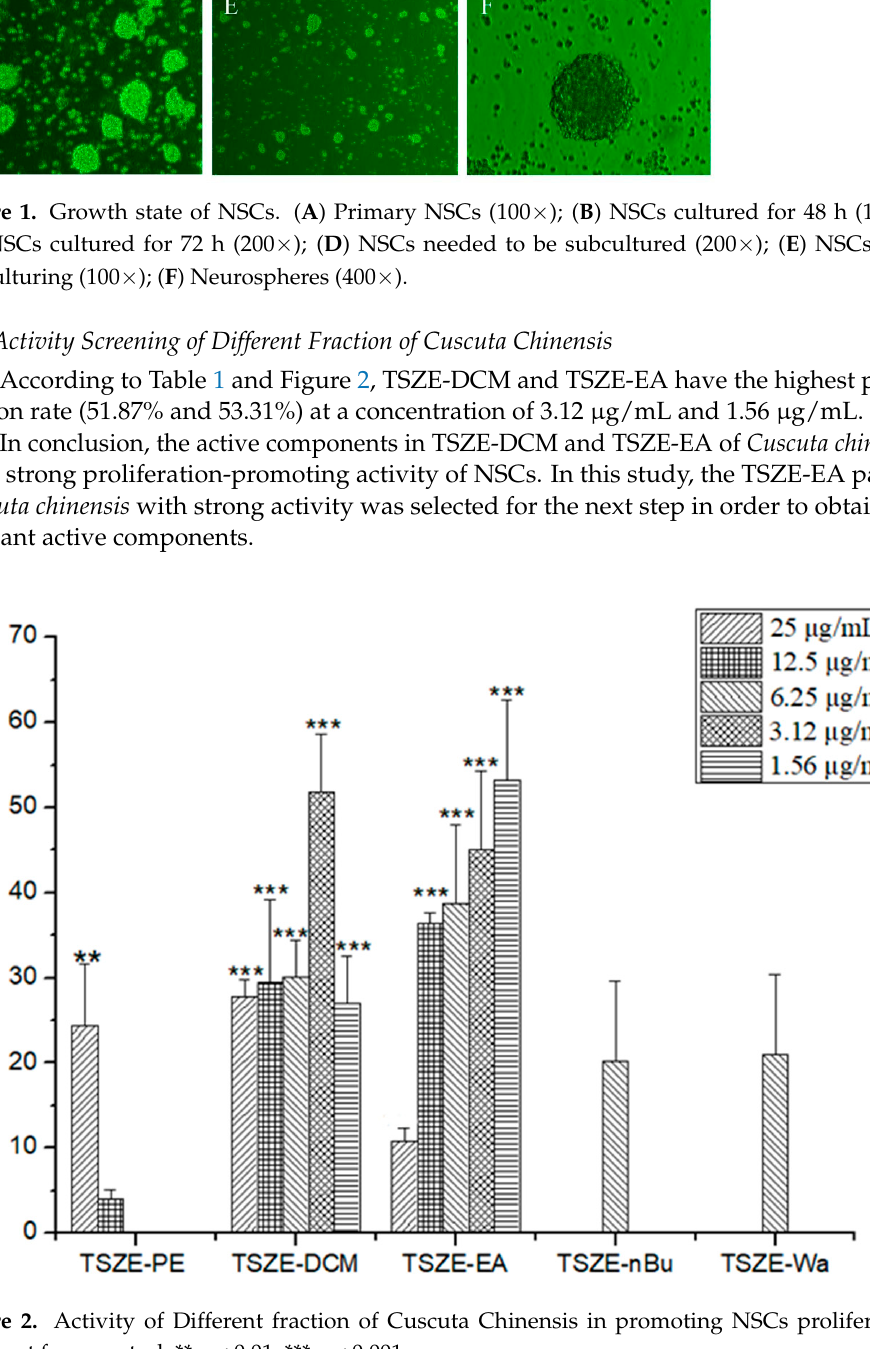
Figure 2. Activity of Different fraction of Cuscuta Chinensis in promoting NSCs proliferation. Different from control, ** p < 0.01, *** p < 0.001.